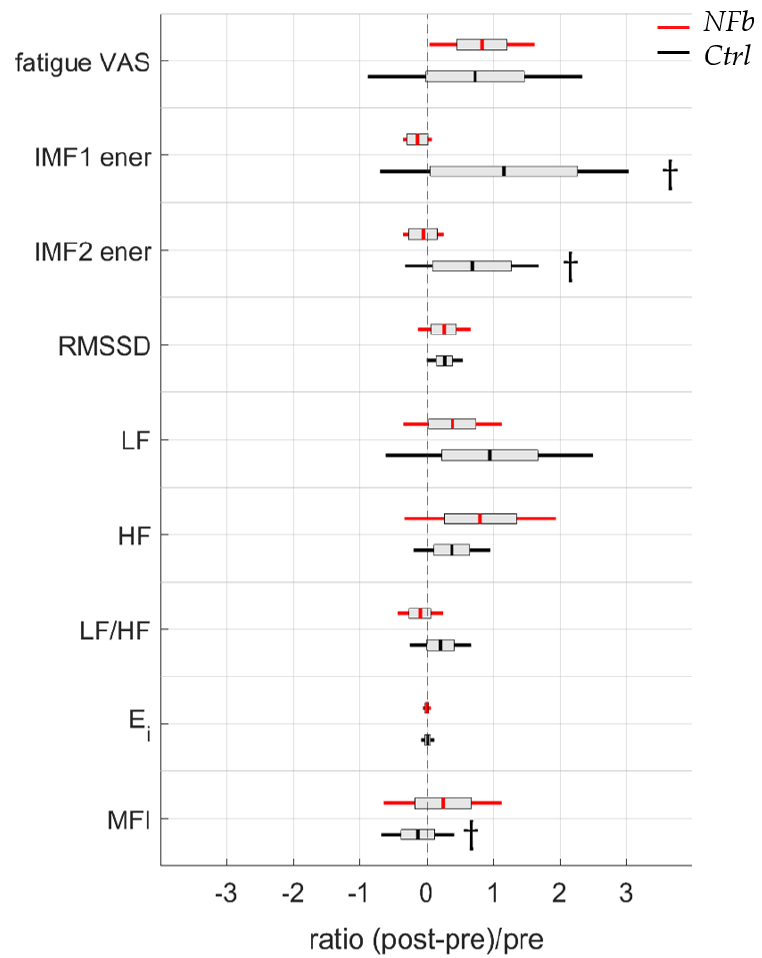
Figure 8. Psychological (visual analogic scale (VAS) of fatigue) and neurophysiological (from C4-EEG and HRV) feature evolution from before and after a neurofeedback training for the NFb group or a control movie for the Ctrl group. IMF = intrinsic mode function; RMSSD = root mean square of successive differences; LF = low-frequency power in HRV power spectrum; HF = high-frequency power in HRV power spectrum; LF/HF = ratio of low frequencies and high frequencies; Ei = entropy index; MFI = multifractal index. † indicates a significant difference considering interaction between time within factor and group between factor.